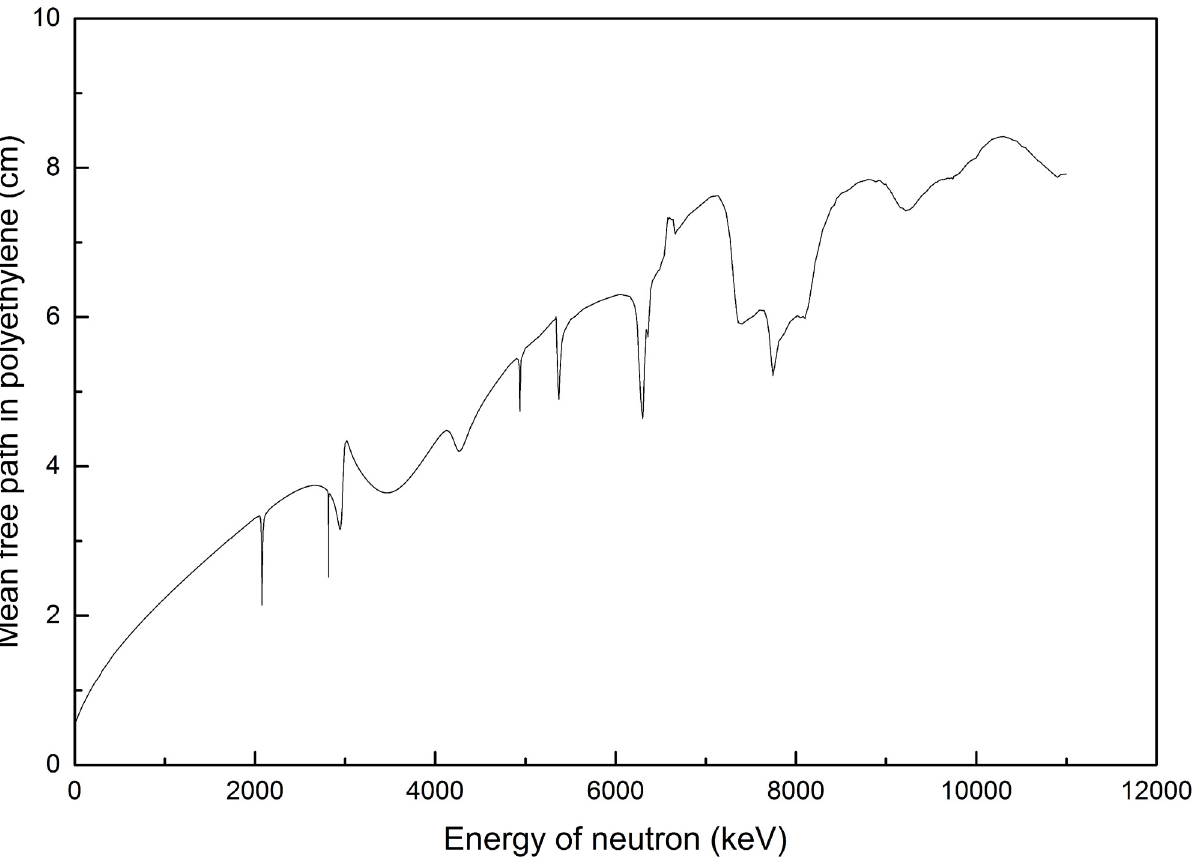
Fig 3. Mean free path for neutrons in polyethylene as a function of the neutron energy.